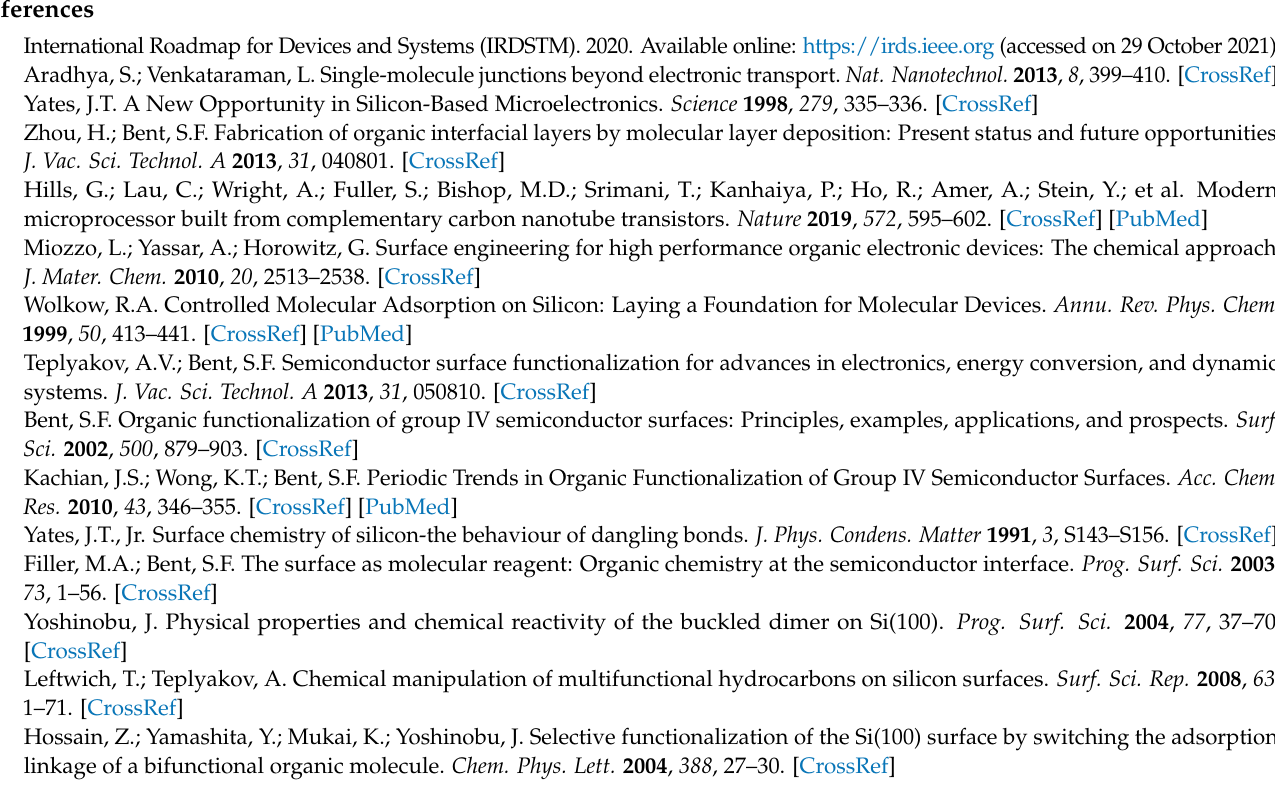
model; Figure S2: Gas phase conformers of ECCO; Table S1: Uncertainty in the Gibbs energy; Figure S3–S6: NOCV deformation densities of the pEDA for single-bonded states; Table S2 and Figure S7–S11: Reaction paths for conformer changes; Figures S12–S16: Reaction paths to doubly bonded structures; Table S3: pEDA values for double-bonded structures; Figures S17–S19: NOCV deformation densities of the pEDA for double-bonded states; Table S4 and Figure S20: